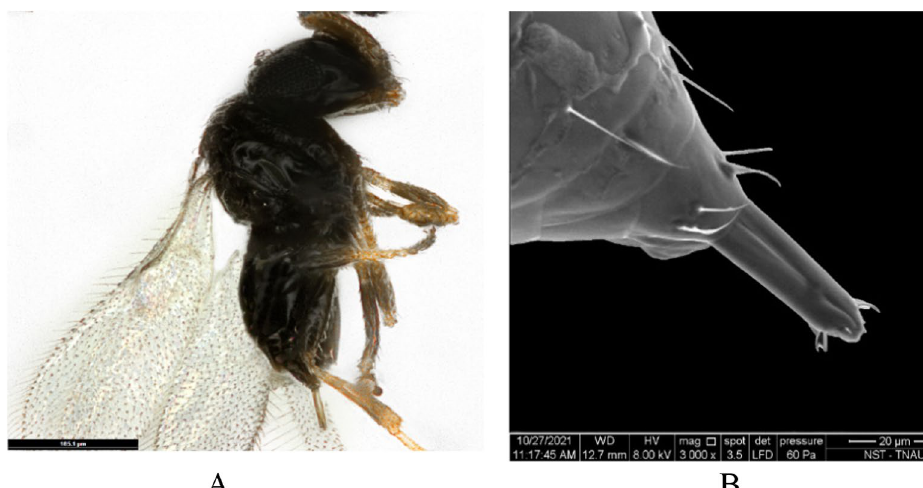
Fig. 14 A, B Female T. remus showing ovipositor